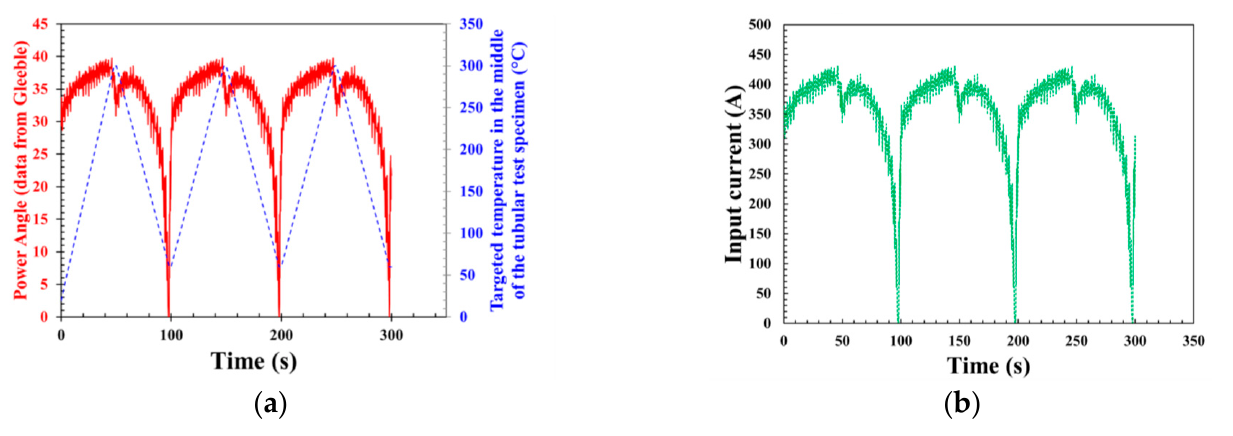
Figure A5. ( a ) Experimental power angle and targeted temperature in the middle of the specimen, ( b ) Input current applied in Comsol.